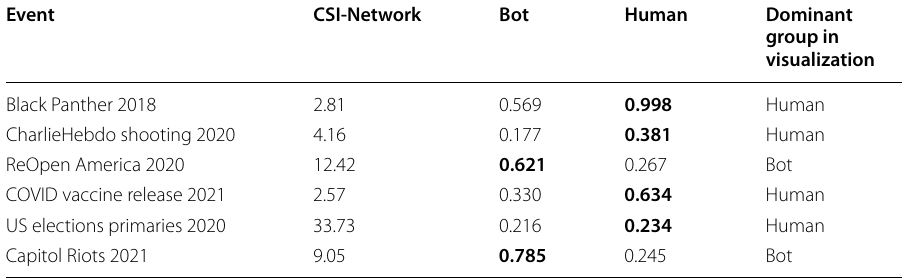
Table 7 Comparison of CSI-Network scores against global clustering coefficient scores derived from the synchronized network graphs